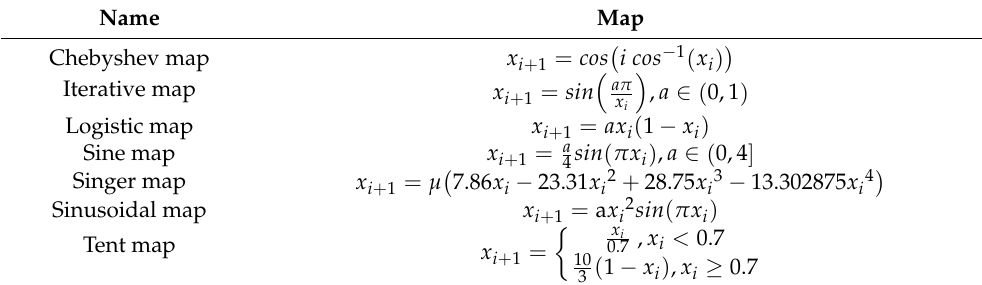
Table 1. Chaotic Functions.